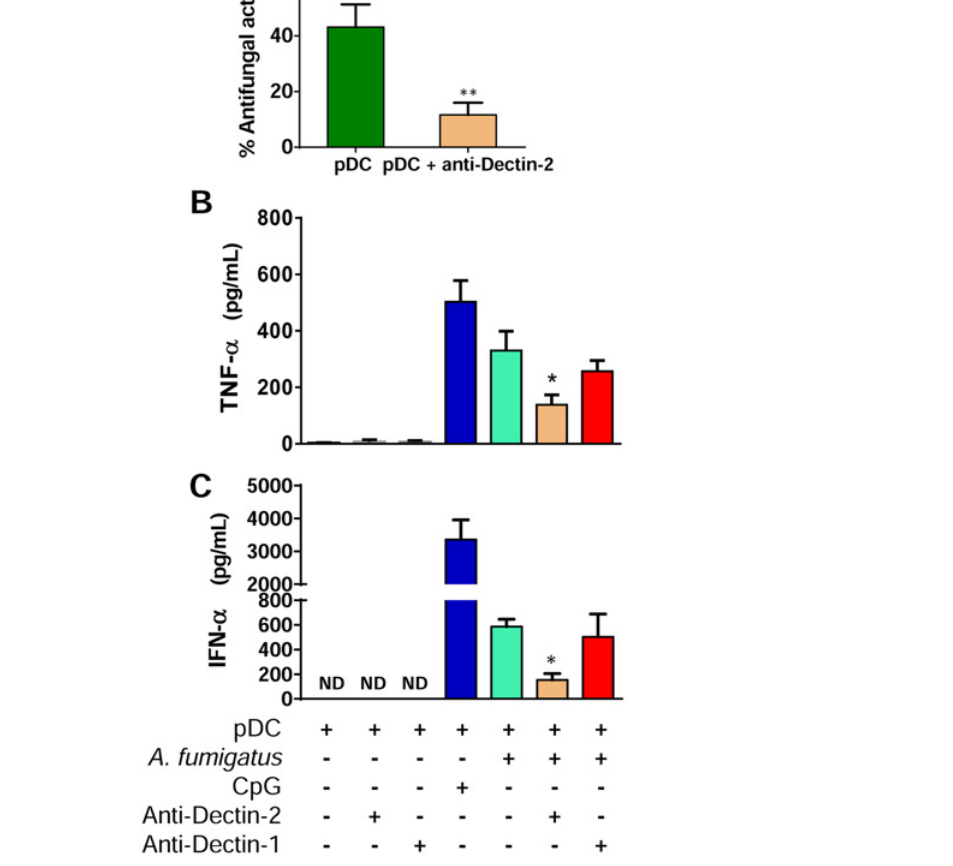
Fig 2. Dectin-2 is involved in antifungal activity and cytokine release by pDCs stimulated with A. fumigatus hyphae. (A) Human pDCs were isolated from PBMCs using magnetic beads. The pDCs (5 × 10 4 ) were incubated with A. fumigatus hyphae (5 × 10 3 ) for 2 hr in the presence or absence of anti-Dectin-2 antibody. Antifungal activity of pDCs was then measured by the XTT assay. Data represent means ± SE from three donors, each tested in triplicate. * P = 0.004. (B-C) A. fumigatus conidia (5 × 10 4 ) were plated in 96-well plates and grown in pDC media to hyphae. pDCs (5 × 10 4 ) were left untreated or incubated with anti-Dectin-2 (100 μ g/mL) or anti-Dectin-1 (100 μ g/mL) antibodies and then added to the hyphae. Control wells contained pDCs only, pDCs and antibodies, or pDC and CpG (10 μ g/mL). After 6 hr, the supernatants were removed and analyzed by ELISA for TNF- α (B) and IFN- α (C). Data represent means ± SE of cytokine concentrations from two (IFN- α ) or three (TNF- α ) pDC donors, each tested in triplicate. * P < 0.05 comparing cytokine secretion by A . fumigatus -stimulated pDCs with A . fumigatus -stimulated pDCs treated with anti- Dectin-2